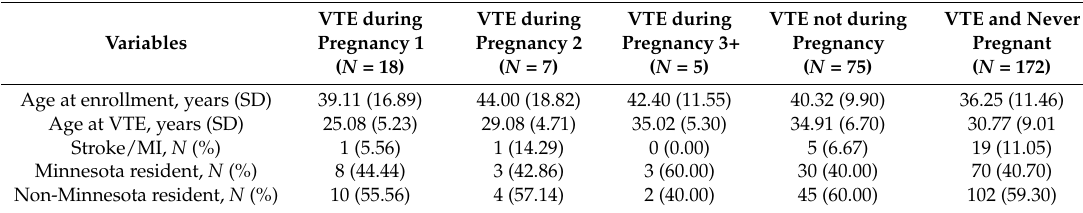
Table 2. Distribution of pregnancies between females and within the pregnant women with VTE events, how many females have VTE at 1st pregnancy, 2nd pregnancy, and 3+ pregnancy (meaning either the 3rd, or 4th or 5th pregnancy and so on).